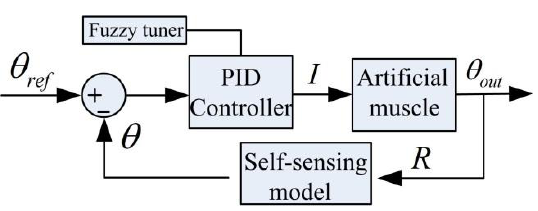
Figure 13. Fuzzy PID control diagram.